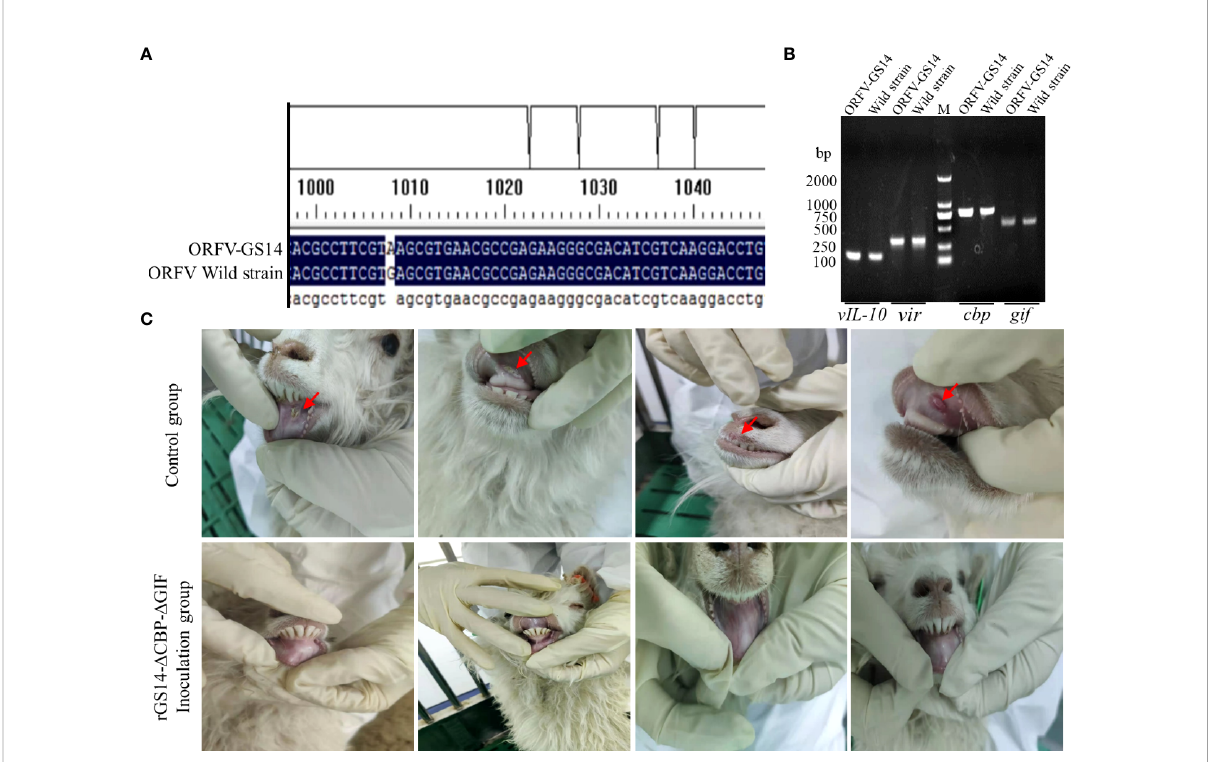
FIGURE 5 Identi fi cation of a wild ORFV used to challenge and the protective ef fi cacy of rGS14- D CBP- D GIF. (A) The existence of main virulence genes was con fi rmed in the genome of the wild ORFV. (B) Sequencing analysis of the wild ORFV compared with ORFV-GS14. (C) Lambs inoculated with rGS14- D CBP- D GIF were all remained healthy compared with the control group.